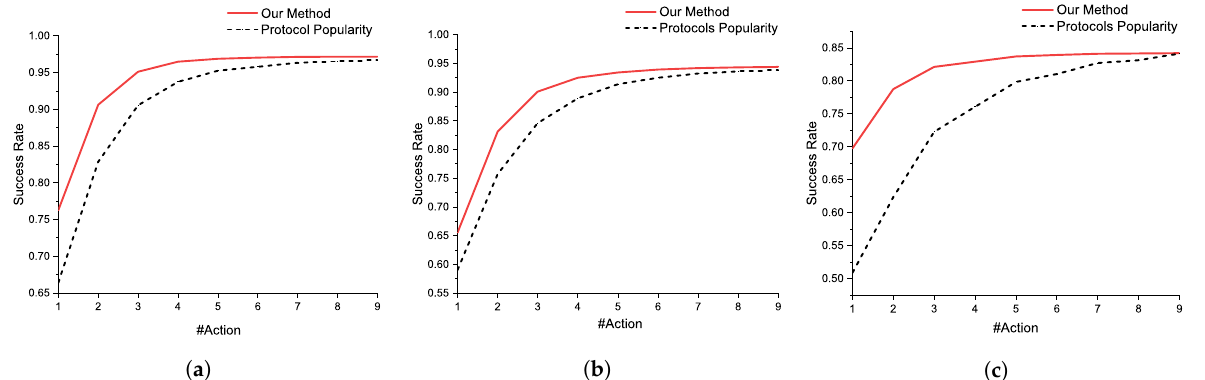
Figure 7. Time efficiency compared with another work: ( a ) success rate of brand; ( b ) success rate of model; ( c ) success rate of